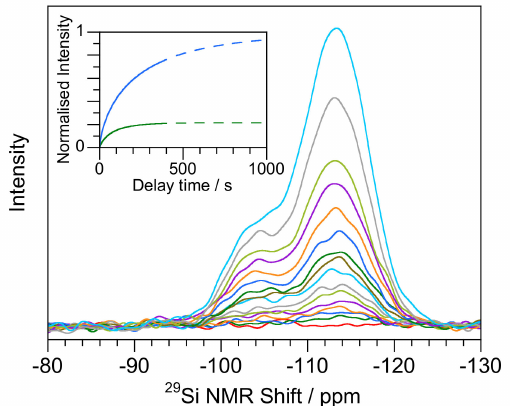
Figure 2. (main) Evolution of signal with delay time for geyserite (G21471 from Rotorua, New Zealand). Delay times are 1, 2, 3, 5, 7, 10, 15, 20, 25, 35, 50, 75, 100, 200 and 400 s (with the zero-time measurement shown in red) (insert) calculated fitting of Q 3 (green) and Q 4 (blue) components using data in Table 2 scaled to Q 4